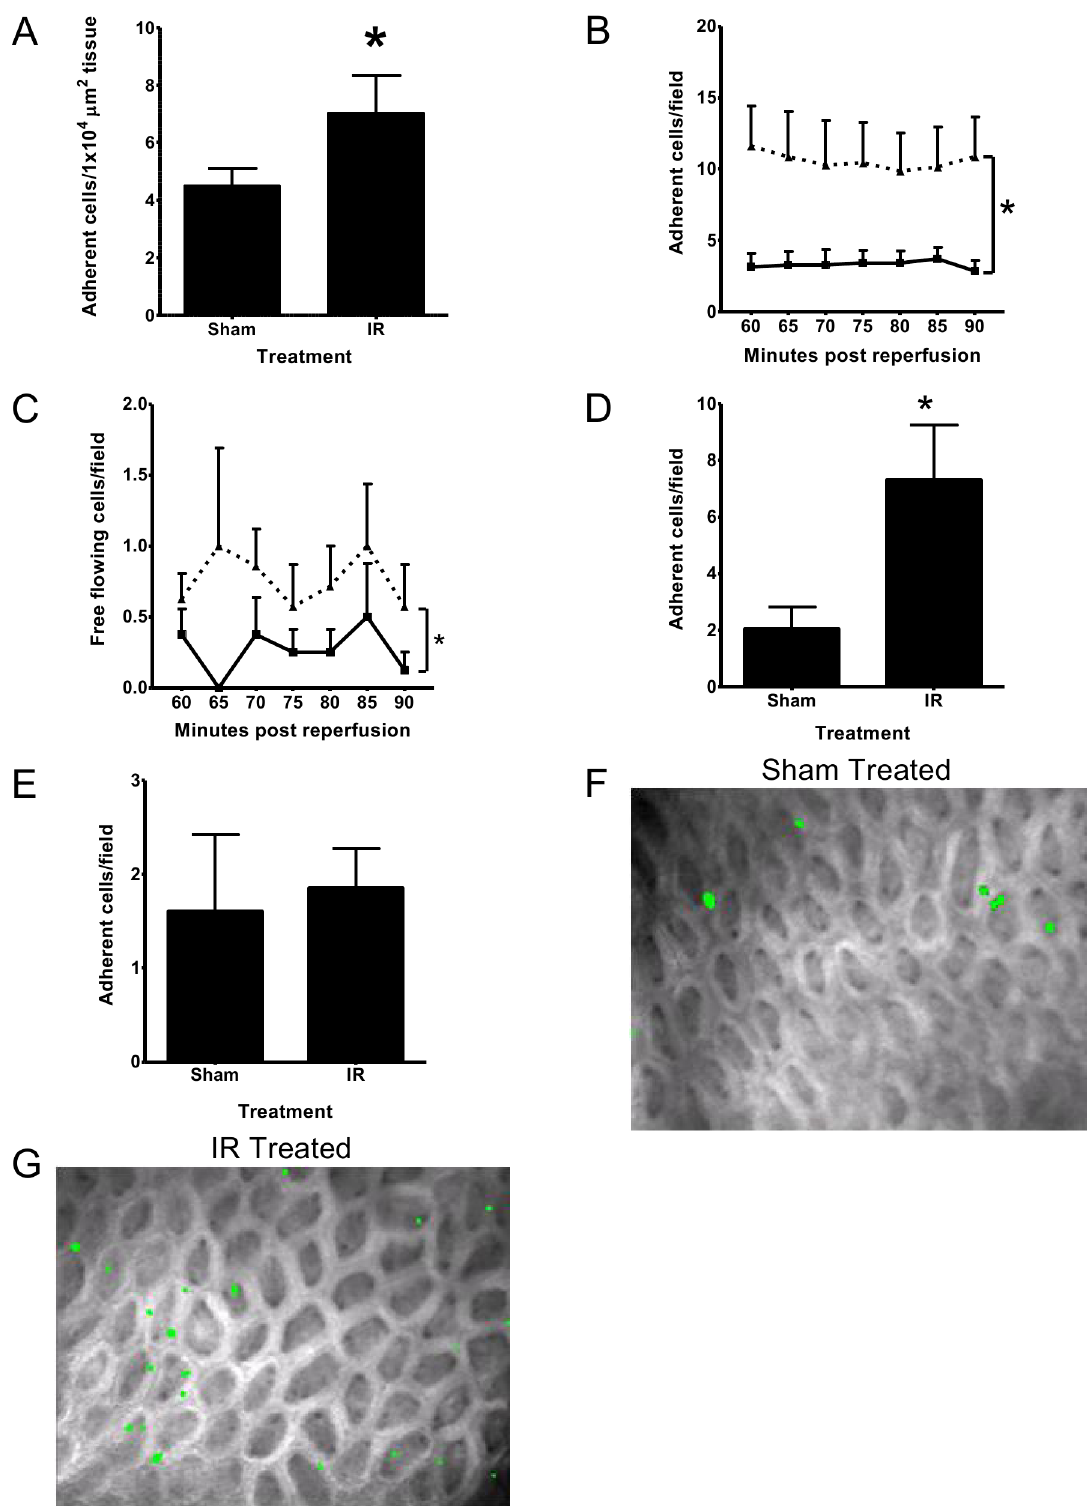
Figure 1. HPC-7 adhesion invitro and invivo is increased on IR injured intestine. (A) HPC-7 adhesion in vitro was raised on frozen ileal sections isolated from IR injured animals when compared to sham controls. Results represent mean adhesion per 1 6 10 4 m m 2 tissue area 6 SEM (n . 4/ group); * p , 0.05. (B) HPC-7 adhesion in ileal mucosal microcirculation in vivo was also raised in animals subjected to IR injury (solid line: sham; dashed line: IRinjury). (C) Free-flowing HPC-7 cells were increased in IR mice(solid line: sham; dashed line: IR injury).(D)IRinjury enhanced HPC-7 adhesion within jejunal villi when quantitated ex vivo. (E) IR injury did not enhance HPC-7 adhesion to duodenum when quantitated ex vivo. Representative images of the villous microcirculation of the ileum in (F) sham and (G) IR animals are shown. Results are presented as mean adhesion 6 SEM (n $ 7/group); * p , 0.05. For frozen section work, data is expressed as mean adhesion per 1 6 10 4 m m 2 of tissue to control for area variation. doi:10.1371/journal.pone.0059150.g001 PLOS ONE |